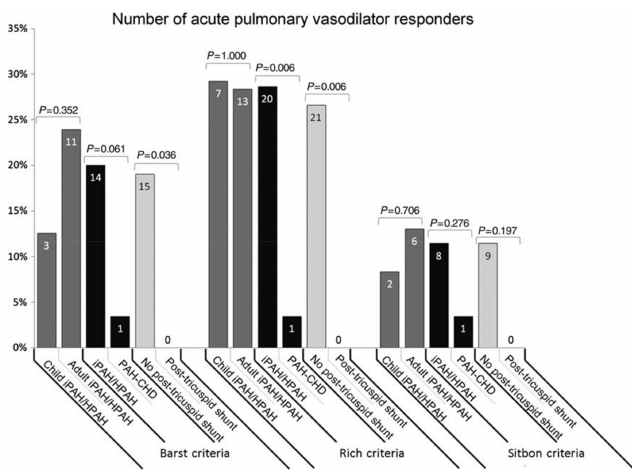
Figure 10. The number of acute pulmonary vasodilator responders according to the three criteria in use, in children vs. adults with idiopathic pulmonary arterial hypertension (IPAH)/hereditary pulmonary arterial hypertension (HPAH), IPAH/HPAH vs. pulmonary arterial hypertension associated with congenital heart disease, and patients without vs. with post-tricuspid shunt, respectively. Data presented as percentage of patient group (%) and patient numbers (indicated in bars). Comparison between groups performed using Fisher’s exact test. Note the few % of patients with PAH-CHD responding to acute vasodilator challenge [114].